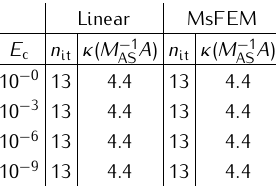
Table 3. Iteration numbers n and condition numbers κ ( M − 1 A ) for Experiment 1; geometry: 1 /h× 1 /h×H/h , h = 1 / 240 , H = 12 h ; linear and it AS multiscale coarsening for different contrasts